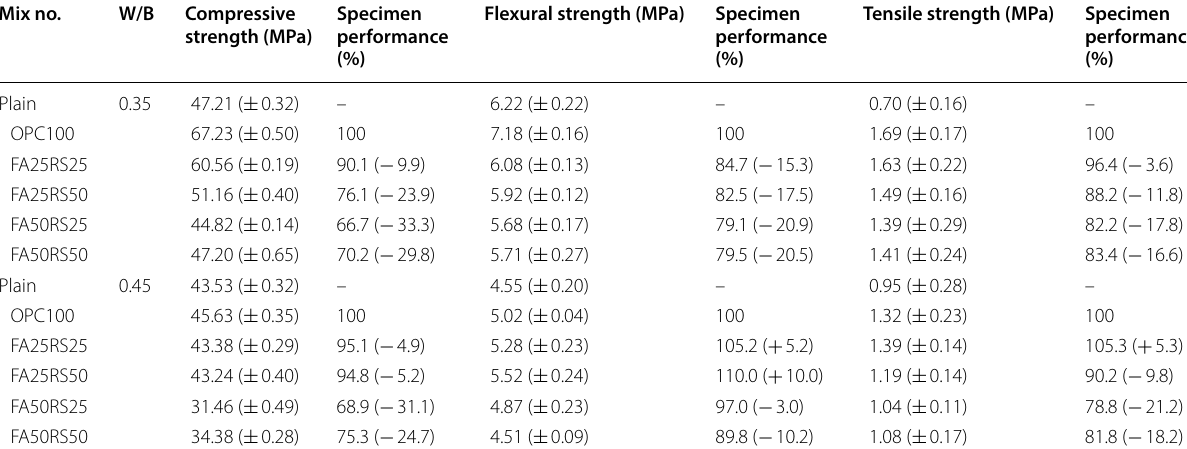
Table 7 Compressive, flexural and tensile strengths of 28-day. Mix no.